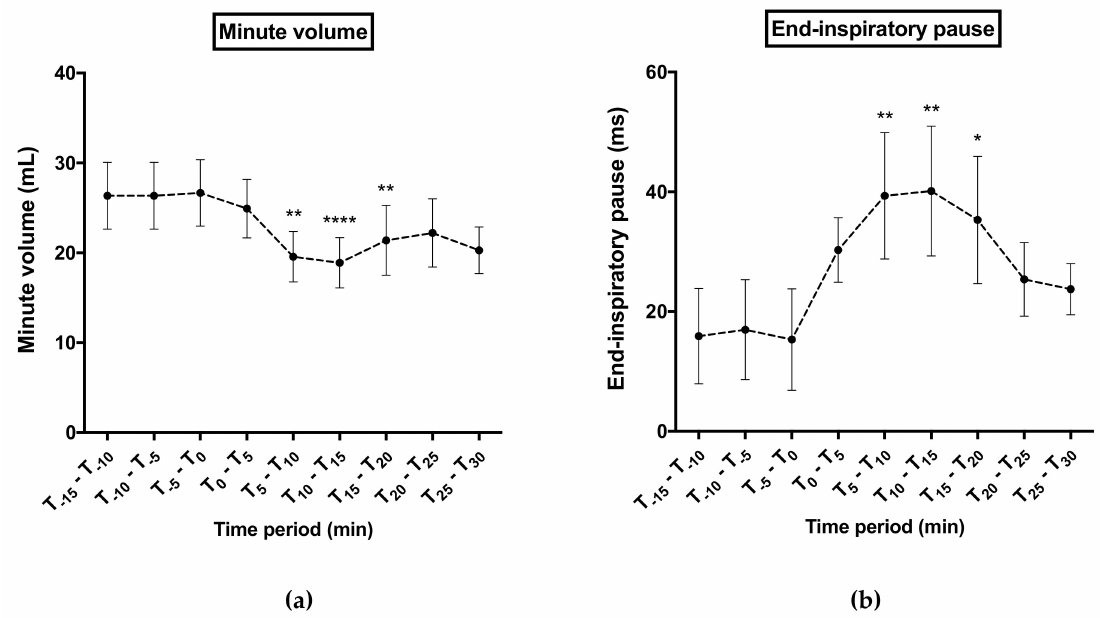
Figure 9. Time course of minute volume ( a ) and end-inspiratory pause ( b ) 15 minutes before 100 µ mol / kg KM297 HCl injection up to 30 min later. Results are presented as the mean of 5 min-means of recordings ± SEM, n = 10. Comparisons were performed using Friedman ANOVA followed by multiple tests using Dunn’s correction with T -5 –T 0 time period considered as the reference period. * p < 0.05, ** p < 0.01, **** p <